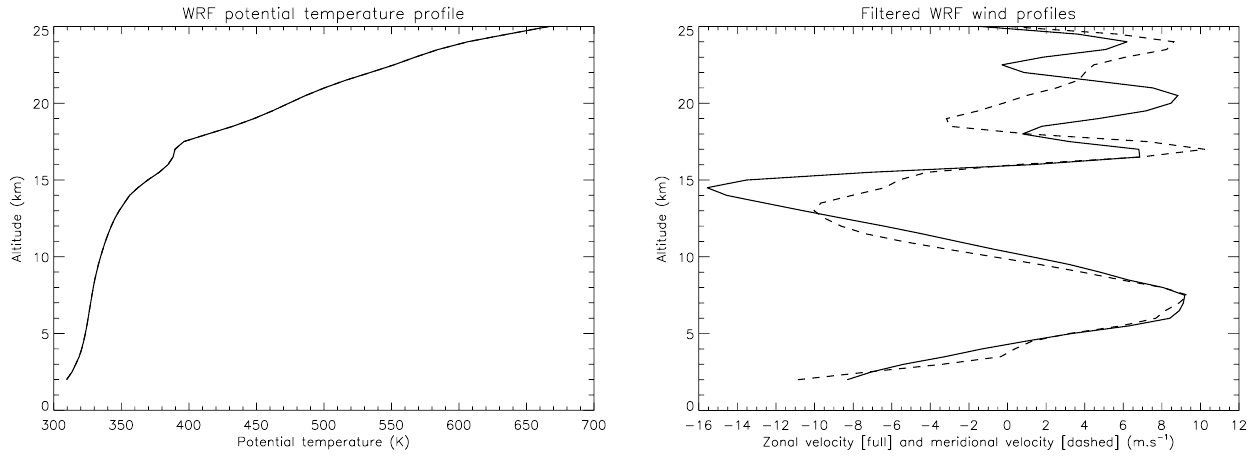
Fig. 19. Case 3: Results of the WRF simulations. Vertical profiles at Salta location. Left: Potential temperature profile (K). Right: Wind profiles (ms − 1) filtered by order 3 polynomial function, combined with a window [2km, ∞] . The wind components are projected on the axes rotated in the horizontal plane in such a way that both wind components are in phase, which allows to identify the steady mountain wave